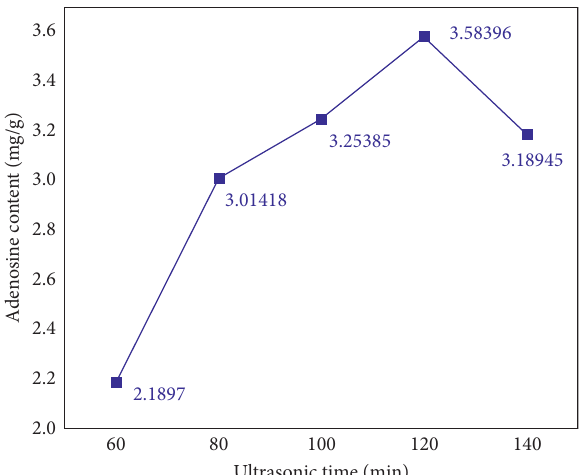
Figure 6: Effect of ultrasonic time on adenosine content.